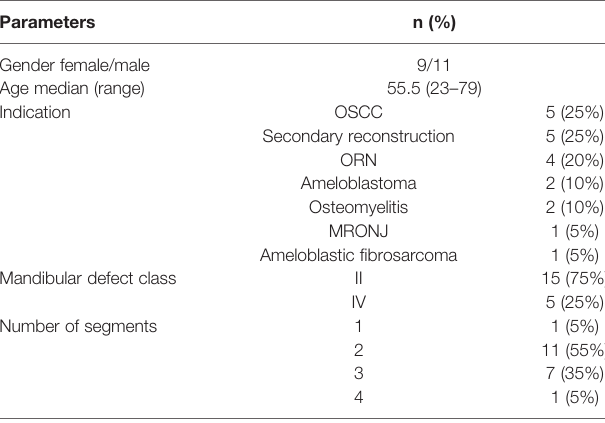
TABLE 1 | Overview of enrolled patients with regard to registered parameters: gender, age, indication for surgery, mandibular defect class according to Brown et al. (17), number of segments.